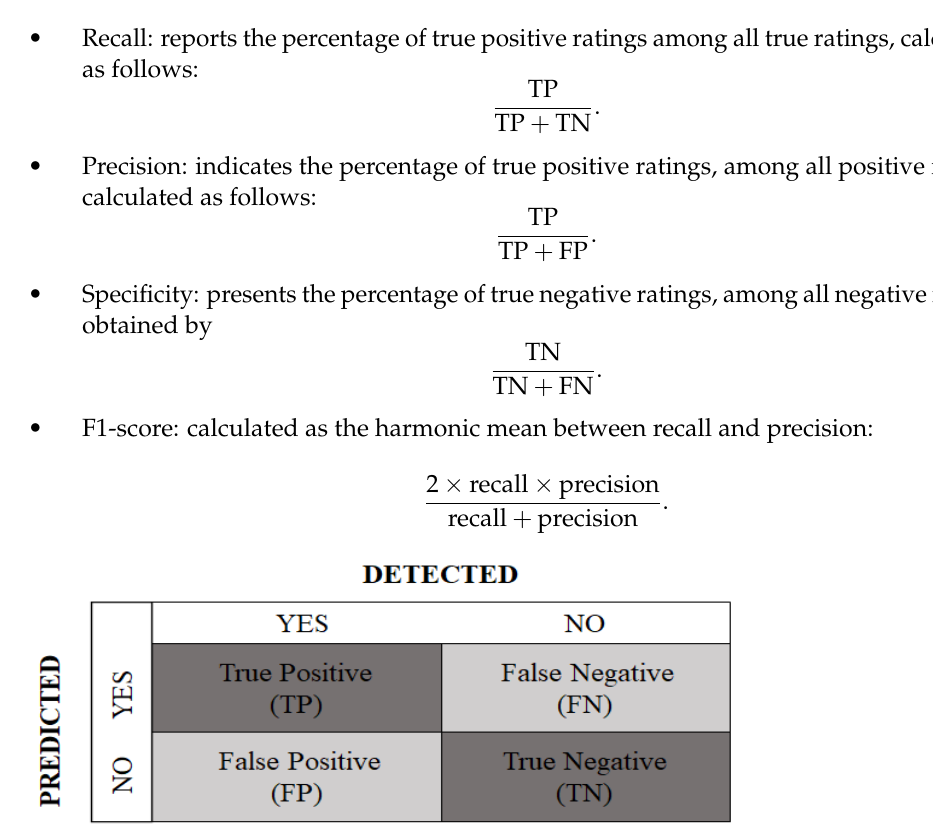
Figure 6. Confusion matrix with predicted classes and detected classes.